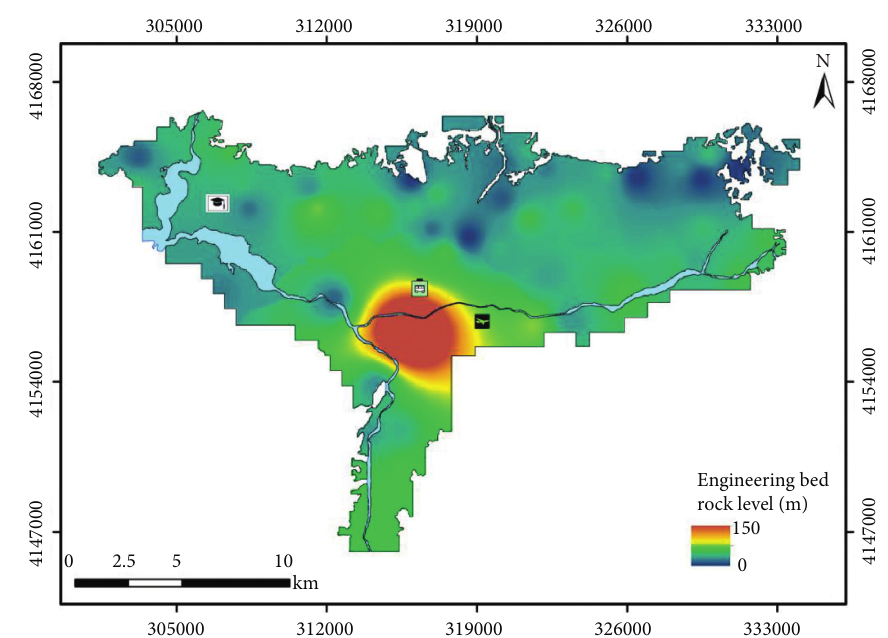
Figure 11: Engineering rock level in Kahramanmaras area using the MASW and MAM